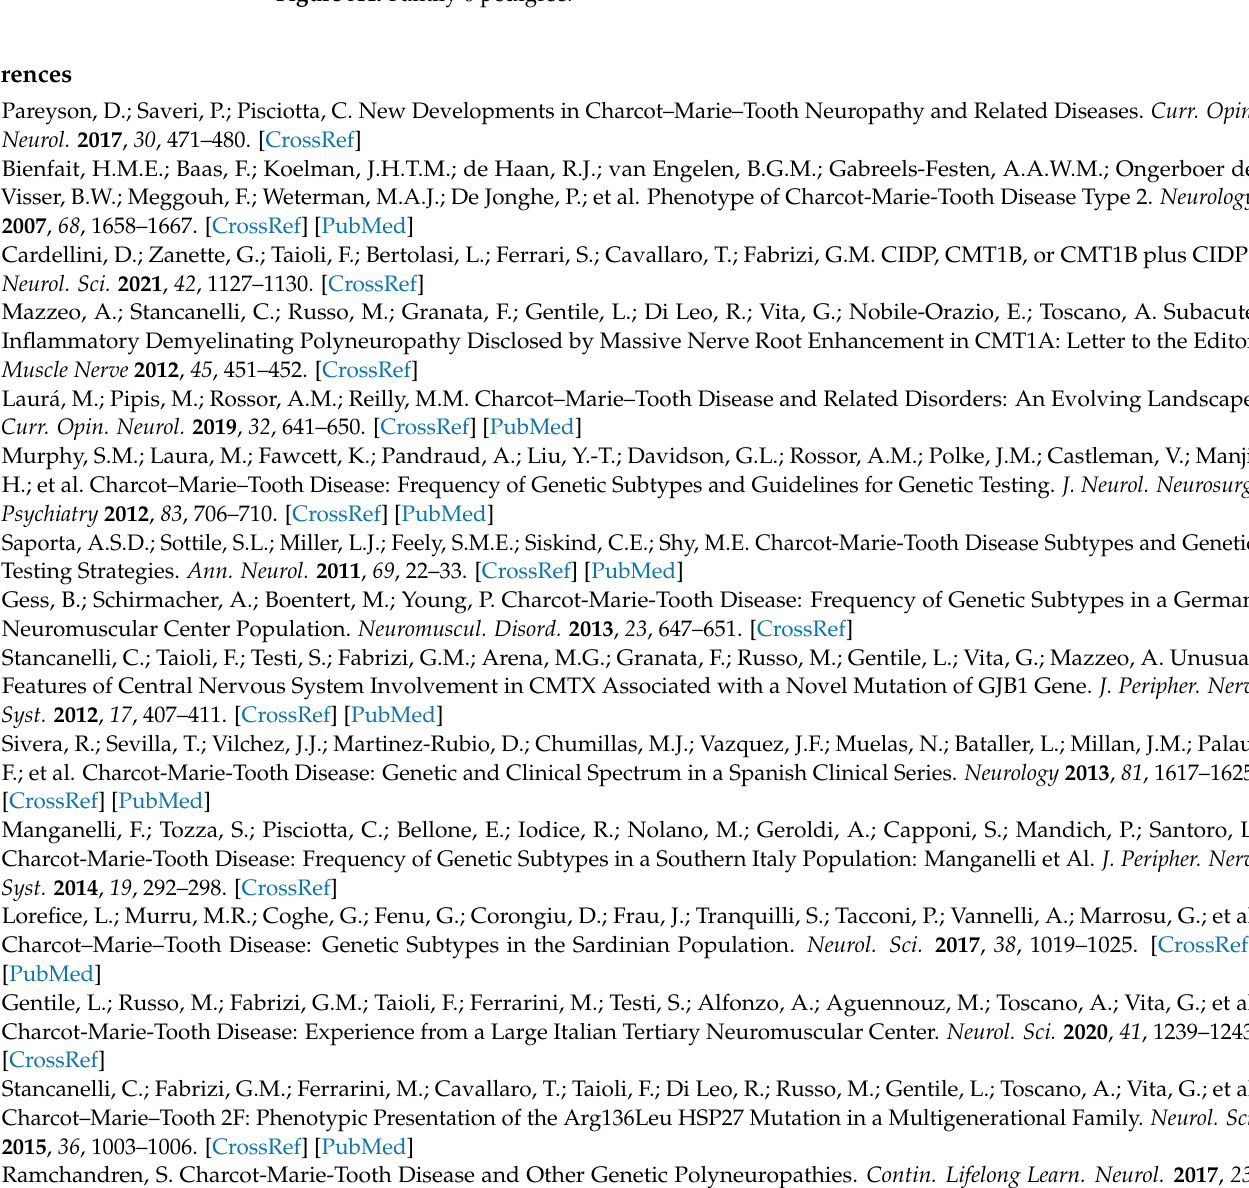
Figure A4. Family 6 pedigree.